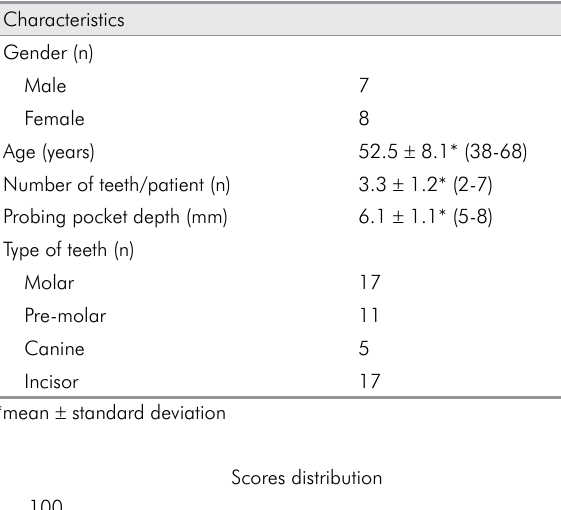
Table. Characteristics of the volunteers and teeth included in the study.